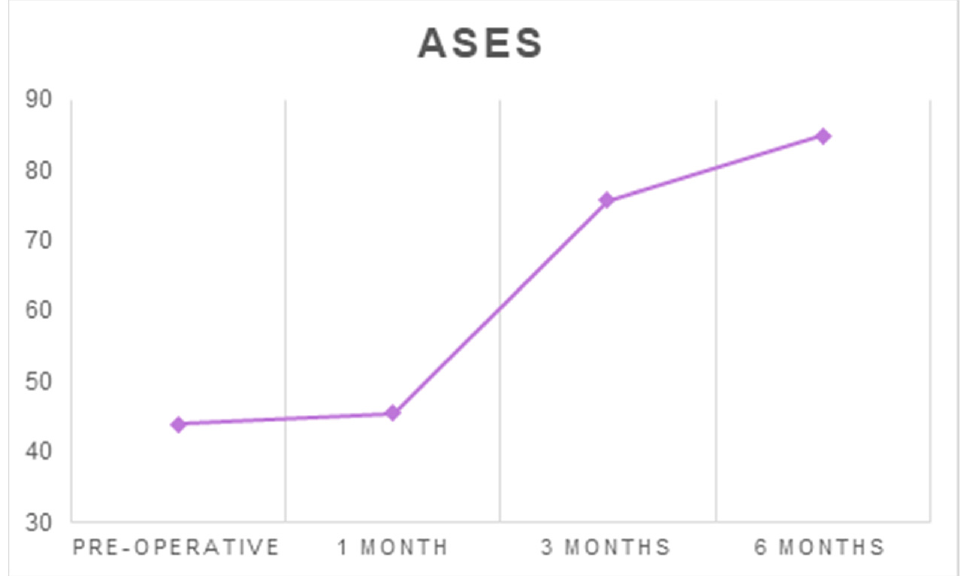
Figure 4. The average ASES at each follow-up timepoint. The mean OSS increased from 36.09 ± 10.96 before surgery to 53.60 ± 5.79 at six months after surgery ( p < 0.001) (Tables 1 and 2, Figure